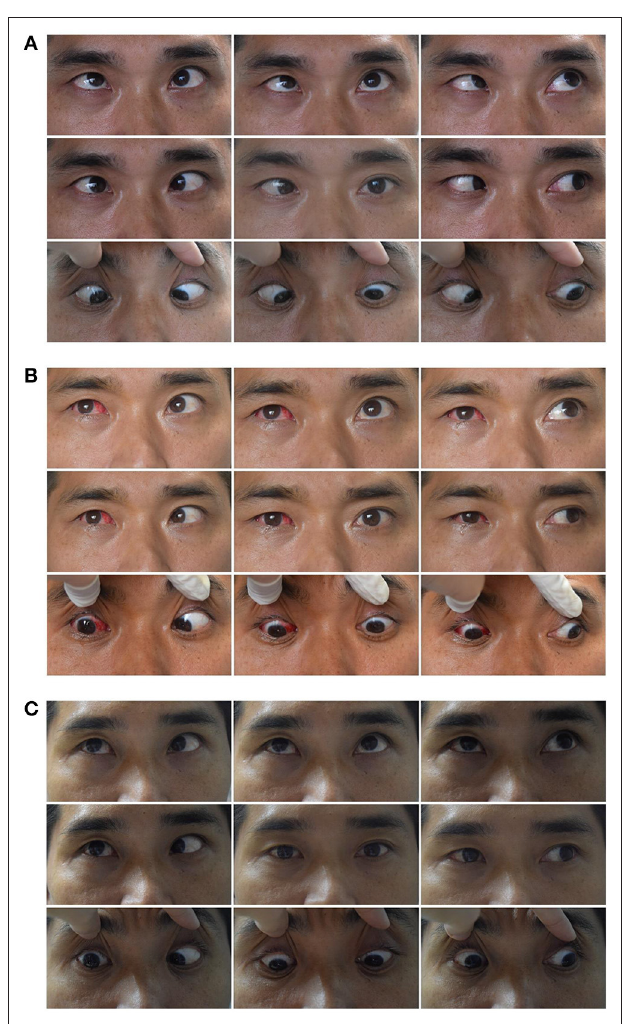
FIGURE 5 | Typical case 3 showed the patient with abduction = 0 on the last visit. A 47-year-old male whose right eye deviated inward for 6 years. He was diagnosed as complete traumatic abducens nerve palsy and received a medial rectus recession of 10mm and lateral rectus resection of 12mm in his right eye while under general anesthesia. The FDT performed during surgery was ( + + + ). (A) The patient’s 9-gaze eye position photo is shown preoperatively with right eye esotropia 60PD (RET = 60PD), abduction-5, adduction + 1.5. (B) 1 day postoperatively with right eye exotropia 20PD (RXT = 20PD), abduction 0, adduction-4. (C) 2 months post-opeatively with right eye exotropia 7PD (RXT = 7PD), abduction 0,